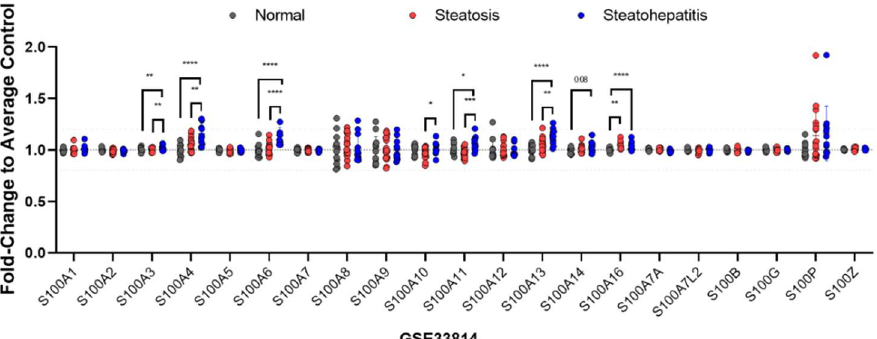
Figure 5. Relative mRNA expression of the different S100 family members in liver biopsies from patients diagnosed with steatosis or steatohepatitis. The relative expression is reported as fold change to control samples (mean +/ − SD). Data were obtained from GSE33814 dataset using the Gene Expression Omnibus (GEO) database. One-Way ANOVA followed by Sidak’s multiple comparisons test was used for comparison between groups. * p -value < 0.05, ** p -value < 0.01, *** p -value < 0.001, **** p -value <